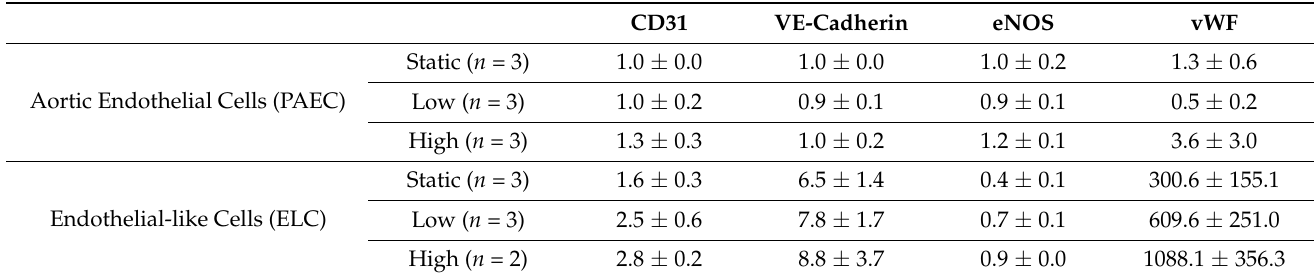
Table 3. Fold-change in mRNA expression of classical endothelial cell (EC) markers under static, low, or high flow conditions. Expression shown as fold change from aortic ECs under static conditions. Mean ± SEM.